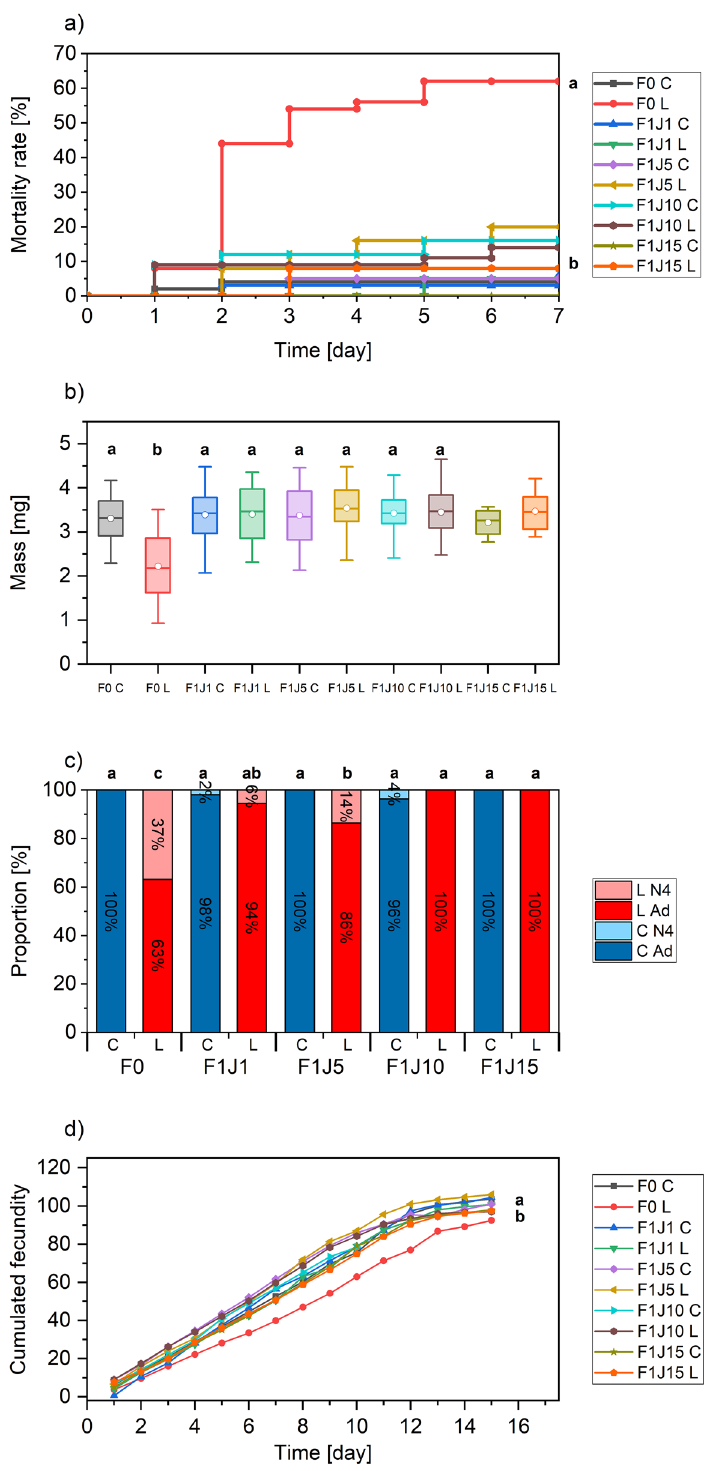
Figure 4. ( a ) Mortality rates over time for the first (F0) and second (F1) aphid generations. F0 C refers to the untreated first generation, while F0 L refers to the irradiated first generation. F1 JX refers to the second generation born the 1st, 5th, 10th and 15th day during the F0 reproduction period (95% interval confidence GLM Gaussian test). ( b ) Aphids’ mass (mg) at day seven (95% interval confidence ANOVA test; sample size F1J15 too small for statistics). ( c ) Proportion of adults (Ad) aphids in samples at day seven. N4 refers to the fourth stage of nymph, which precedes the adult stage (95% interval confidence χ 2 and Fisher tests). ( d ) Evolution of cumulated fecundity (95% interval confidence GLM Poisson